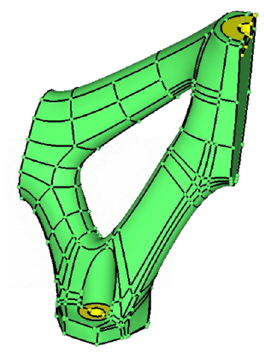
Figure 8. Geomatical model of the optimized topology design.